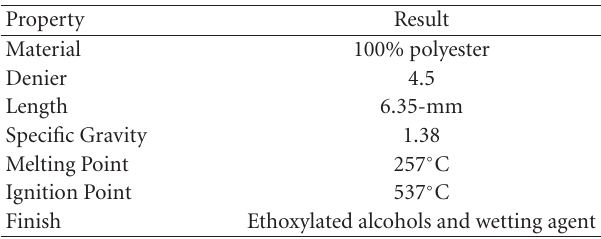
Table 1: Properties of fibers used in Phase 1 (provided by the man-